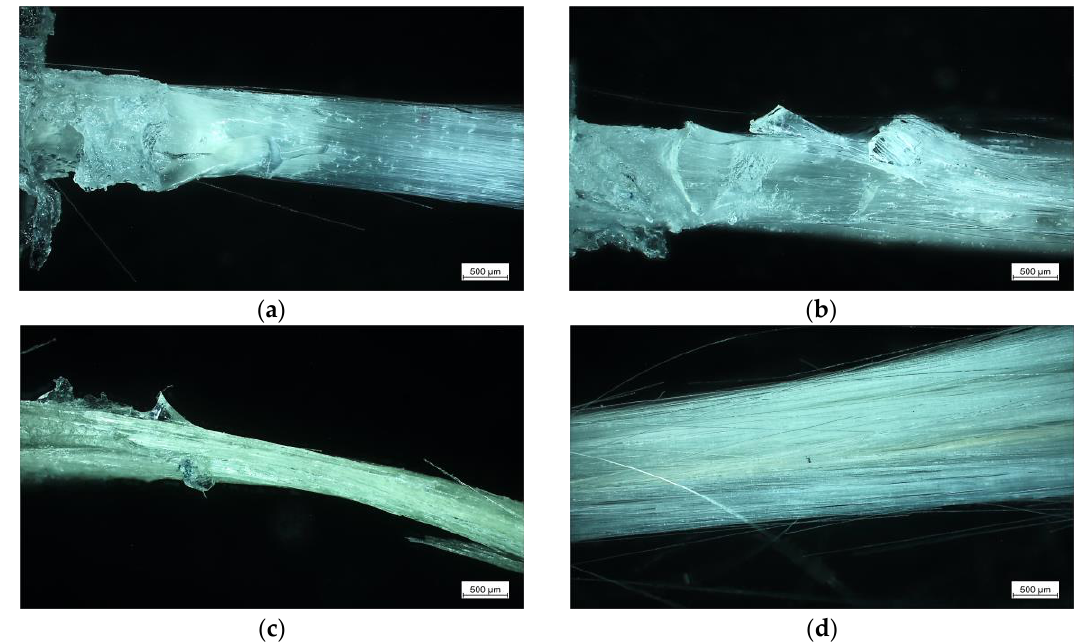
Figure 6. Light micrographs after the fiber bundle pull-out test of VTES-modified GF ( a ), GF desized with acidic and basic piranha solution ( b ), APTES-modified GF ( c ), GF sized from the supplier ( d ).